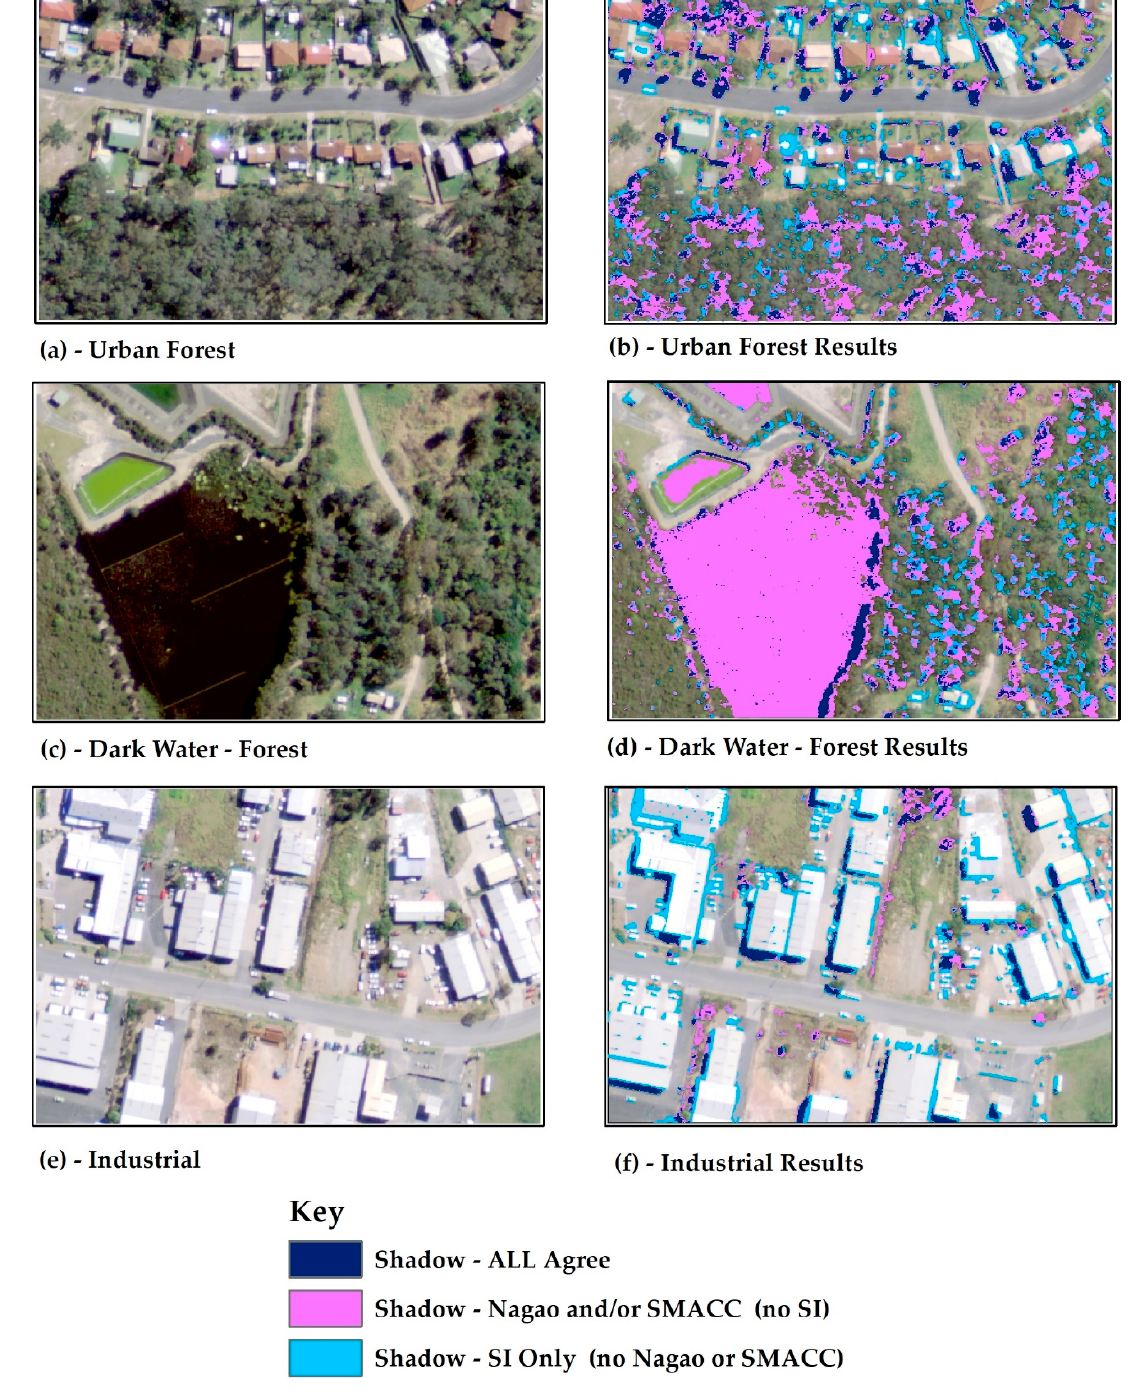
Figure 6. Shadow detection results for ADS40 image subsets. Binary shadow masks from SI, Nagao and SMACC methods are combined into three display classes. Subsets ( a , c , e ) are original images and subsets ( b , d , f ) are respective shadow detection results.